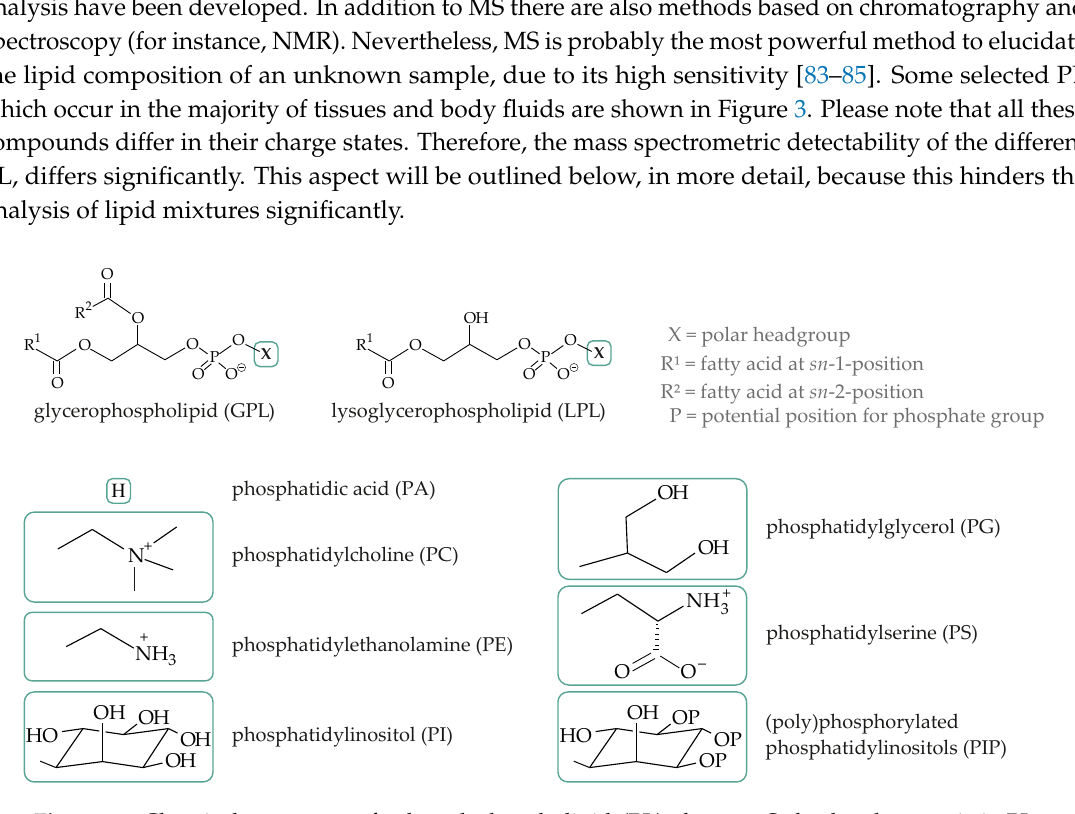
Figure 3. Chemical structures of selected phospholipid (PL) classes. Only the characteristic PL headgroups are shown. “R 1 ” and “R 2 ” denote different acyl (or in selected cases also alkyl) chains. Please note that the majority of physiologically-relevant lipids possess a saturated and an unsaturated fatty acyl moiety at the sn-1 and the sn-2 position, respectively. Although there also are alkyl-acyl and alkenyl-acyl PL, only the ester-linked compounds are shown